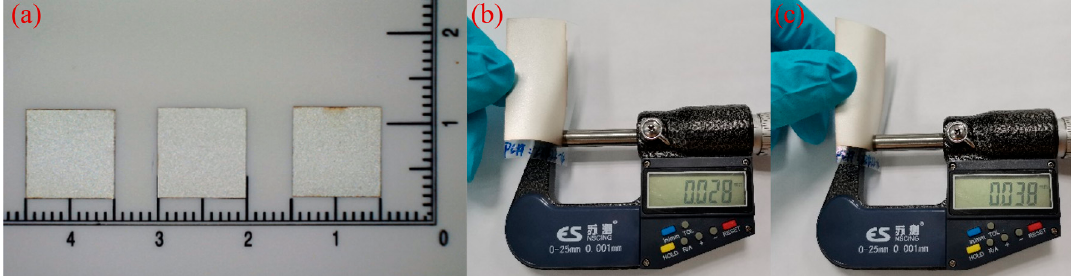
Figure 2. The images of square PVDF films ( a ), and the thickness measurements of uncoated PVDF film ( b ), and one-side Ag coated PVDF film ( c ).